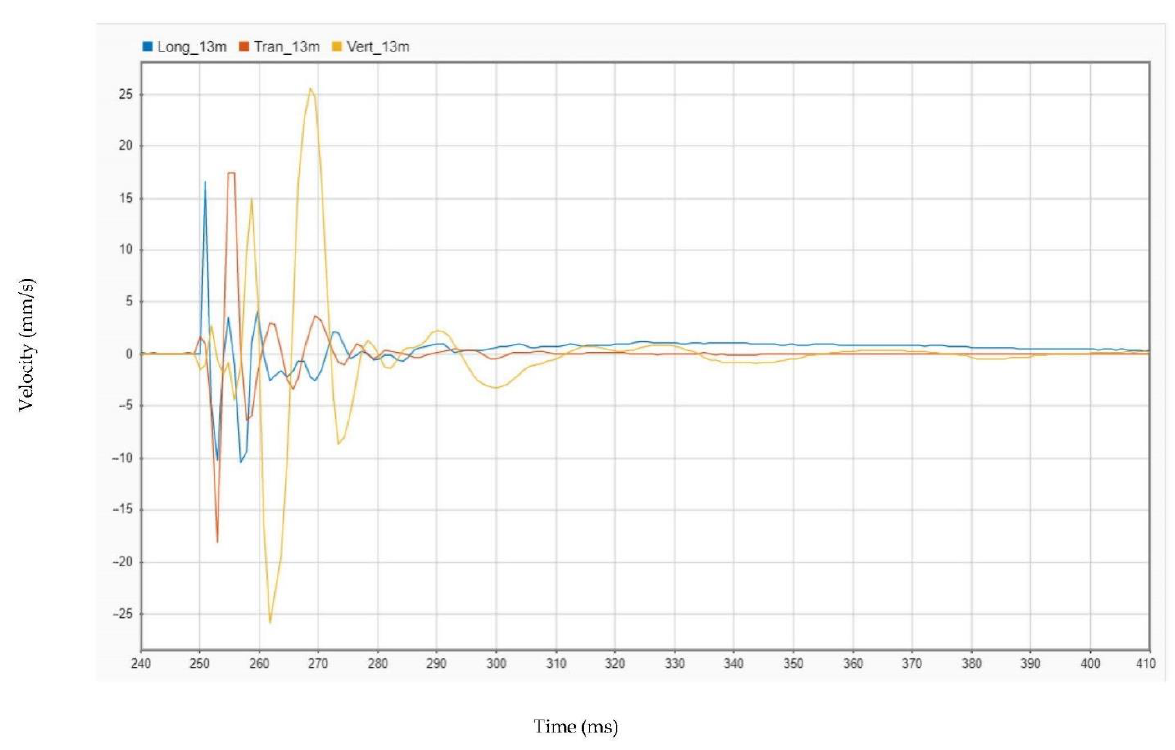
Figure 3. Three components of ground velocity at 13 m. The seismograms were processed in several ways, as described below. The Fourier transform provides the spectra as shown in Figure 4. Table 1 presents the dominant frequency and amplitude for every component of the signal.